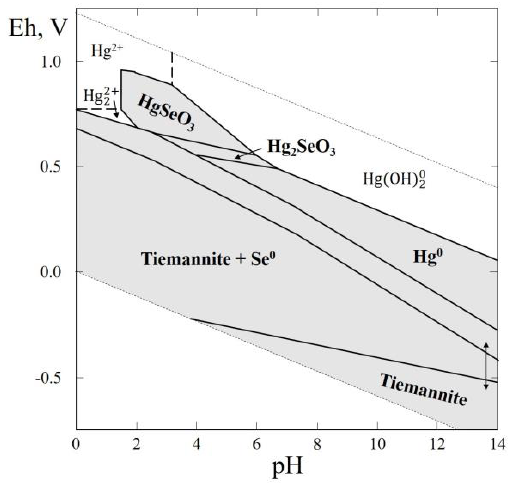
Figure 9. Eh-pH diagram of the OHSeHg (Hg-Se-H 2 O) system at 25°C and the activities of the components: a ΣSe = 10 − 4 , a ΣHg = 10 − 5 . The dotted lines are the boundaries between fields of Hg 2+ , Hg 22+ , and Hg(OH) 20 .